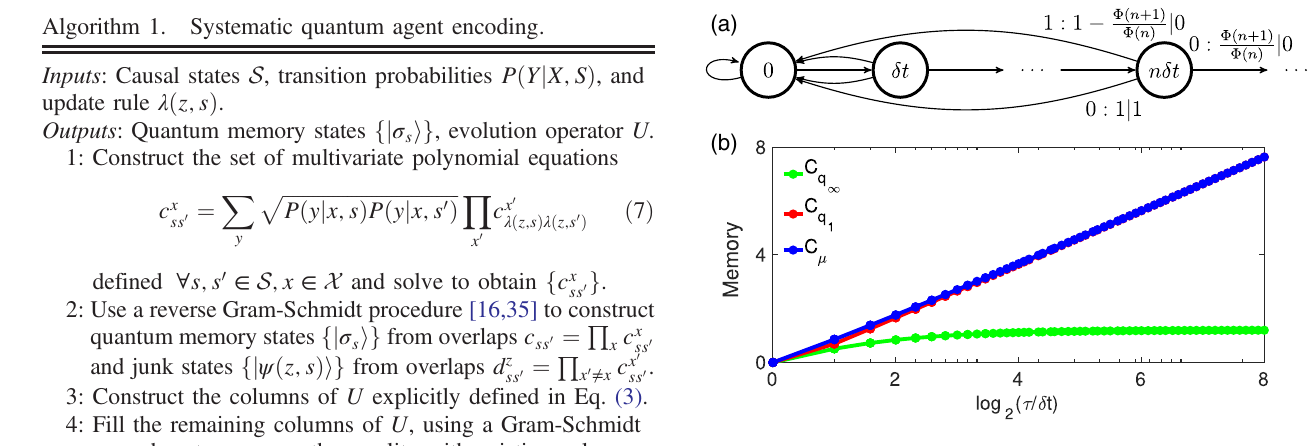
FIG. 3. Unbounded scaling advantage. (a) Hidden Markov model representation of resettable stochastic clocks. State labels represent the number of time steps since the last event; Φ ð n Þ ≔ R ∞ ϕ ð t Þ dt is the survival probability. (b) Associated memory n δ t costs for executing such a strategy, showing the advantage of our quantum agent ( C q ) growing unbounded relative to previous ∞ quantum ( C q ) and minimal classical agents ( C μ ) with refinement 1 of time